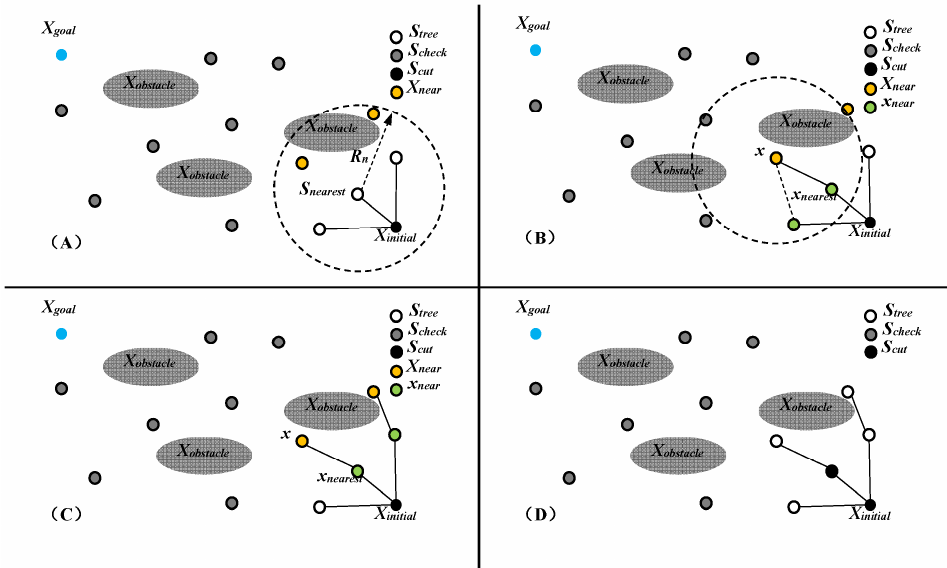
Figure 3. Schematic diagram of the iterative process of the FMT* algorithm. Sub-figure ( A ) shows the neighborhood point X near . Sub-figure ( B ) shows the connection of a new branch. Sub-figure ( C ) shows the all branches added based on X near . Sub-figure ( D ) shows the one step result of FMT*. In the FMT* algorithm, the set S is divided into three subsets: the node set S tree of the tree, the candidate point set S check and the pruning set S cut . S tree includes sampling points that have been added to the path tree and continue to participate in the next step of the path tree growth; S check includes all sampling points that have not been tested; S cut in- cludes sampling points that have been added to the path tree but are pruned during the growth of the tree The next sampling point no longer participates in the further growth of the path tree. At the beginning, the FMT* algorithm puts X initial in S tree and all other sampling points in S check , while S cut is an empty set; then, the algorithm finds the shortest point in S tree from the X initial path S nearest and finds S nearest in S check . The neighborhood point X near is shown in Figure 3(A); for each sampling point x in X near , in turn, find its neigh-